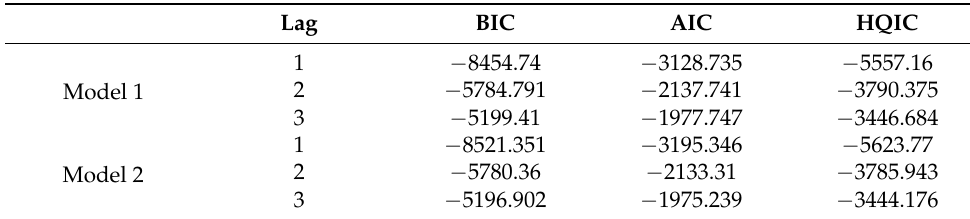
Table 3. The choice of lag order.